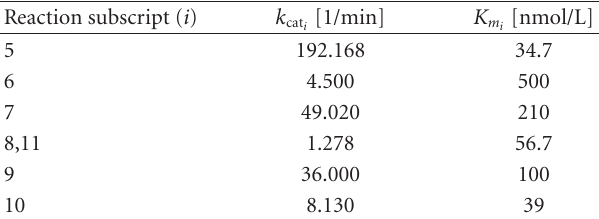
Table 1: Parameters for System of Di ff erential Equations [6].